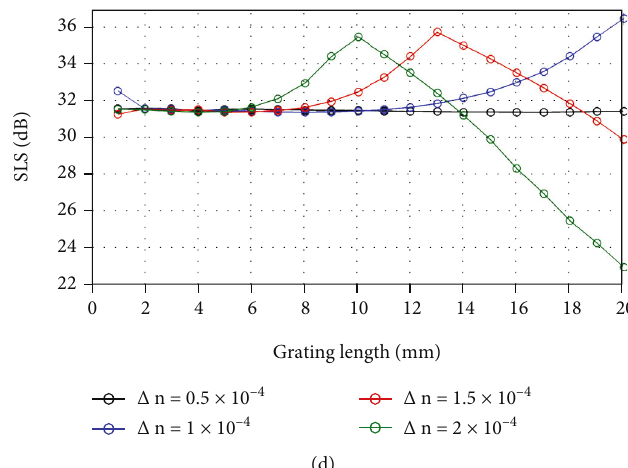
Figure 8: FBG side-lobe suppression versus grating length of FBG with (a) uniform, (b) Gaussian, (c) sine, and (d) raised sine apodization.